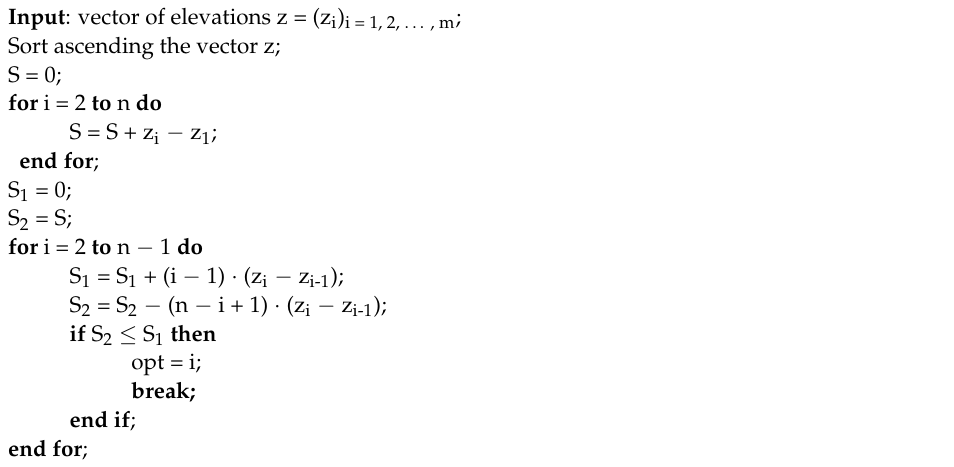
Algorithm 5 Height of Excavation/Filling Plane (AHEFP)